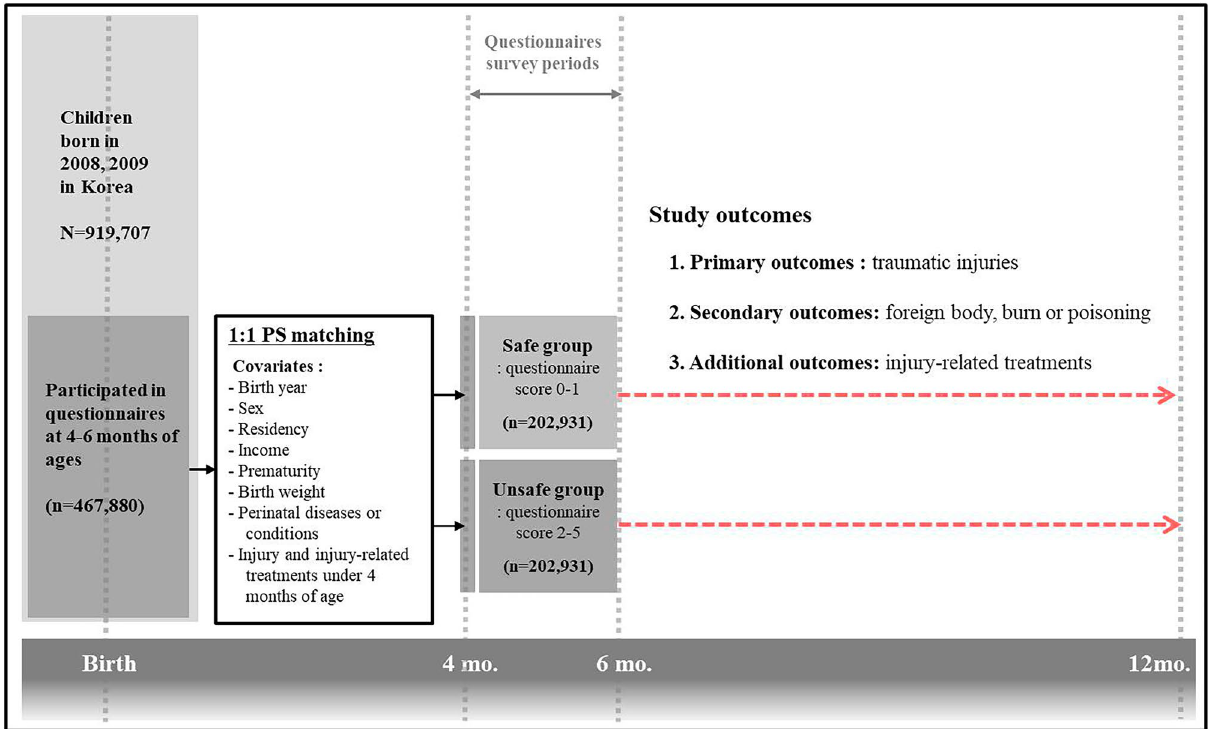
Figure 1. Study design. A total of 917,707 children were born in Korea from 2008 to 2009, and the parents or caregivers of 467,880 of them answered a safety-related questionnaire when they were 4 to 6 months-old. Propensity score-matching was used to balance the covariates between the “safe group” and the “unsafe group”. These covariates included demographic and clinical characteristics, injury diagnosis, and treatment for an injury before age 4 months (Supplementary Table S1). After matching, 202,931 children were assigned to each group. The primary outcome was traumatic injury, the secondary outcome was non-traumatic injury, and the additional outcome was treatment for an